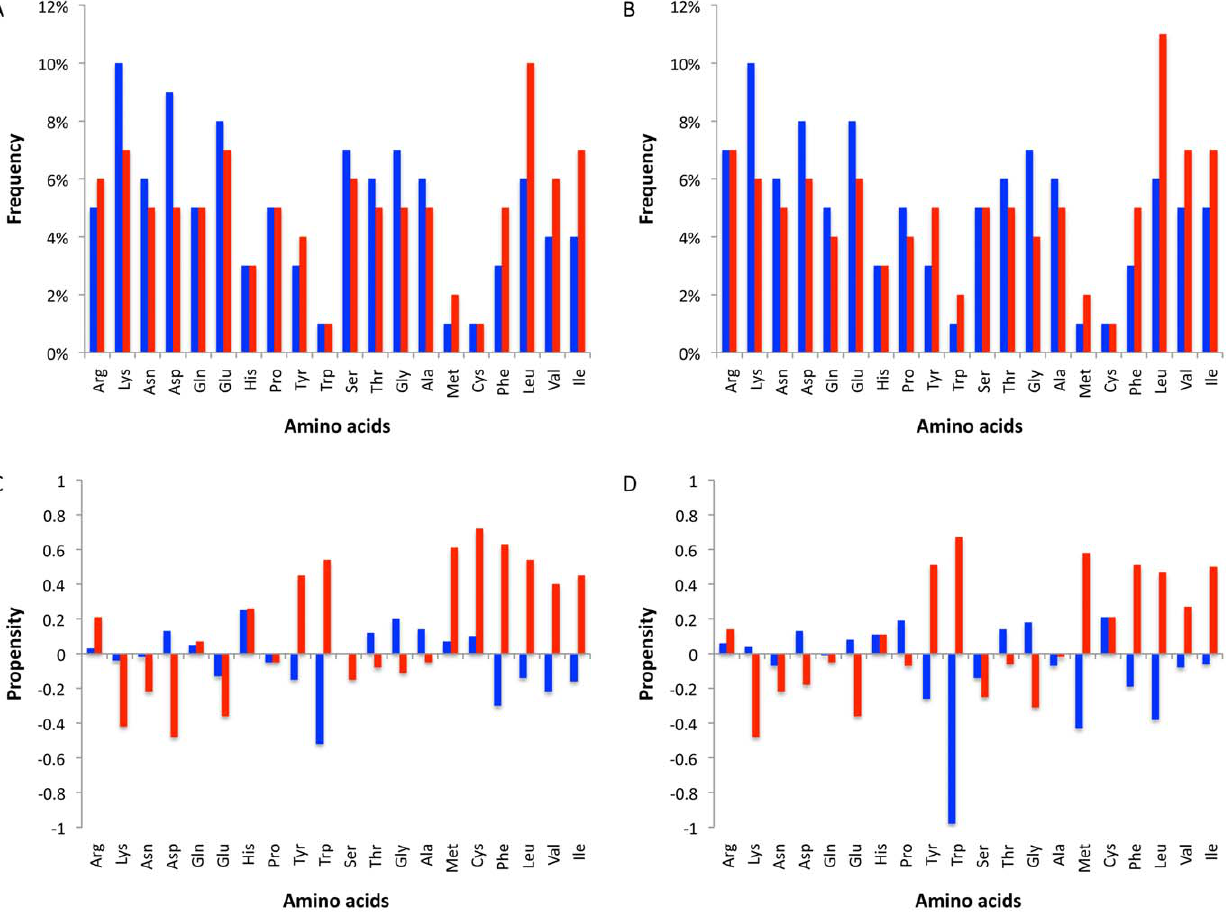
Figure 2. Amino acid composition of interfaces. A. Frequency of residues in homocomplexes. B. Frequency of residues in heterocomplexes. C. Propensities of residues to be in the interface in homocomplexes. D. Propensities of residues to be in the interface in heterocomplexes. Blue bars correspond to the rim area, whereas red bars correspond to the interacting residues. Amino acids are sorted using Kyte and Doolittle table [46], which ranks residues according to their hydropathy. Frequency is based on the number of residues, whereas propensity takes into account the accessibility of each residue in the monomer. doi:10.1371/journal.pone.0021053.g002 PLoS ONE |